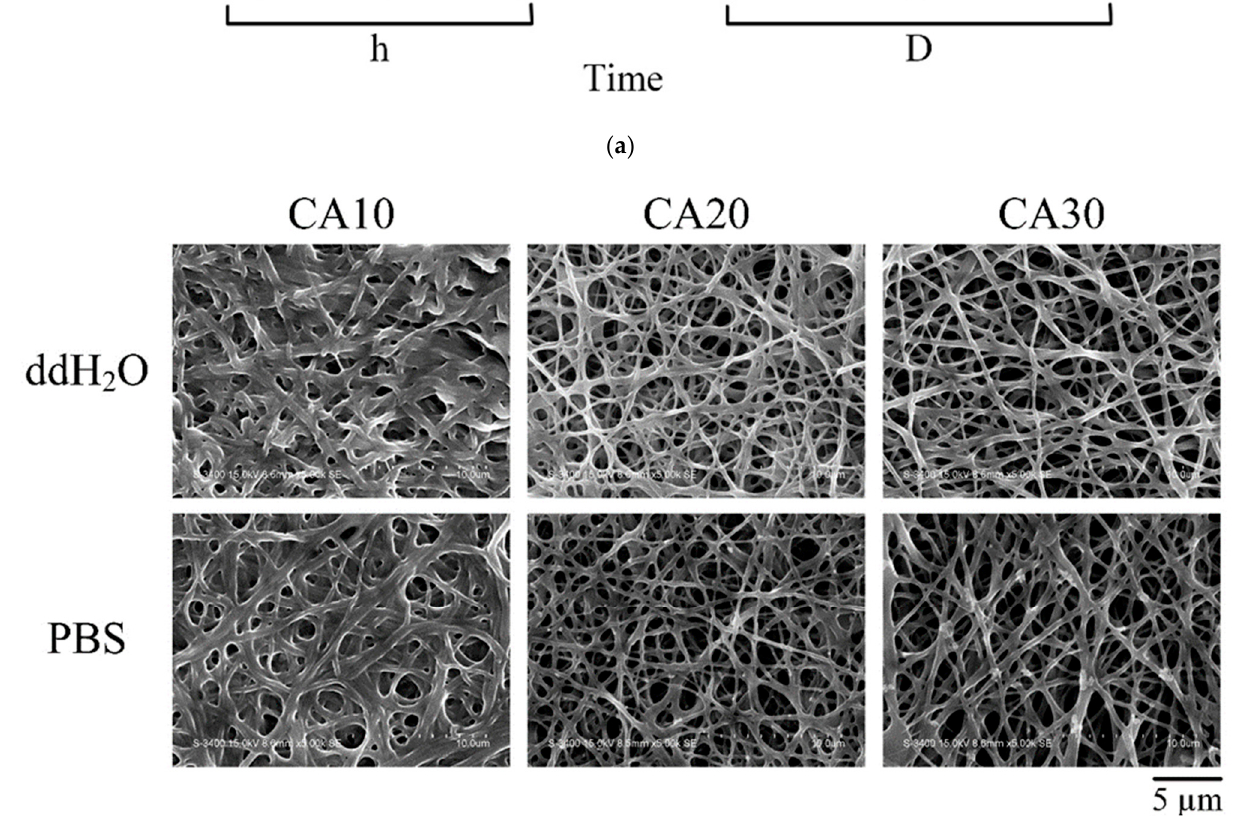
Figure 5. ( a ) Swelling behavior measured by weight change of PVA membranes crosslinked with CA of different concentrations soaked in ddH 2 O for 3 days ( n = 12; vertical error bars represent uncertainty (standard deviation) in parameter CA). ( b ) Morphological changes of different membranes after soaking in ddH 2 O and PBS for 3 days.